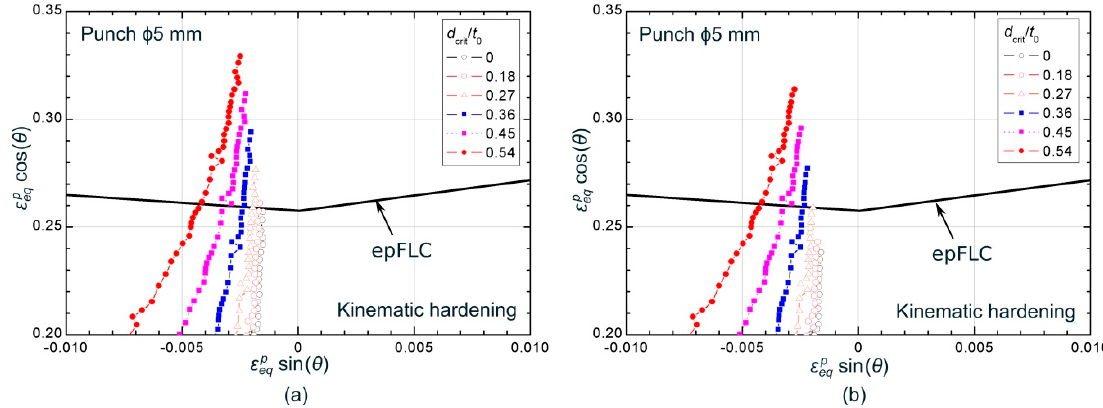
Figure 14. Equivalent plastic strain evolutions within the polar space, averaged at different values of d crit , for the φ 5 mm stretch-bending tests at the time instants at which numerical paths for ( a ) d crit = 0 and for ( b ) d crit = 0.27 t o achieved the epFLC.